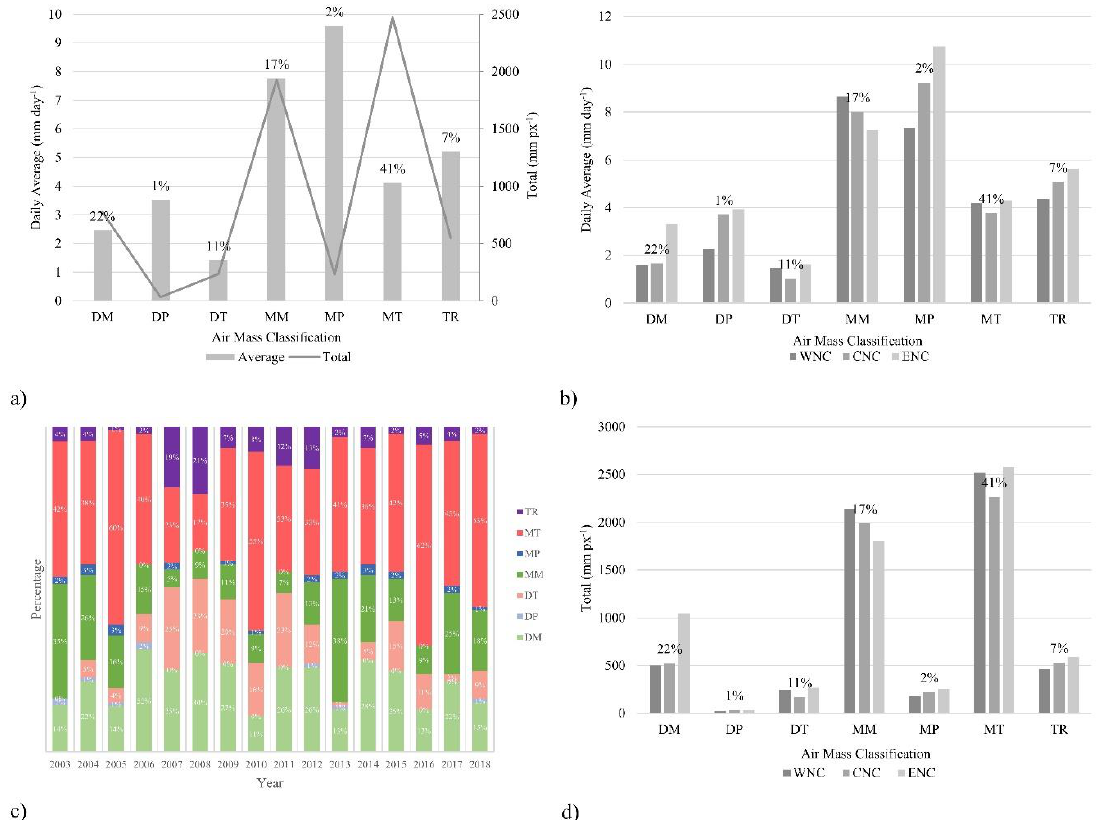
Figure 8. ( a ) summer (JJA) statewide daily average precipitation and total precipitation for each SSC air Figure 8. Same as Figure 4 but for summer (JJA). mass classification; ( b ) daily average precipitation for each North Carolina region; ( c ) frequency of each Figure 8. Same as Figure 4 but for summer (JJA).